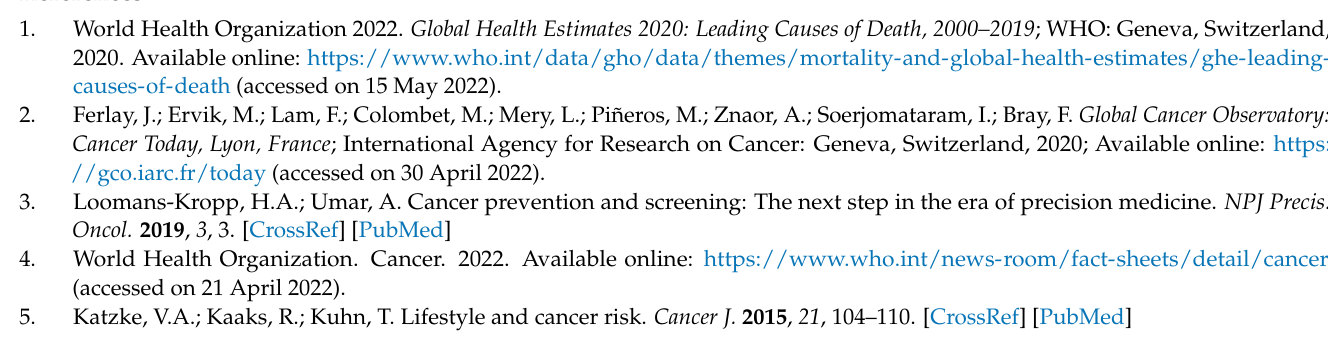
database, Table S2. List of excluded studies and reasons for exclusion, Table S3. The quality assessment of the included studies, in alphabetical order and based on study